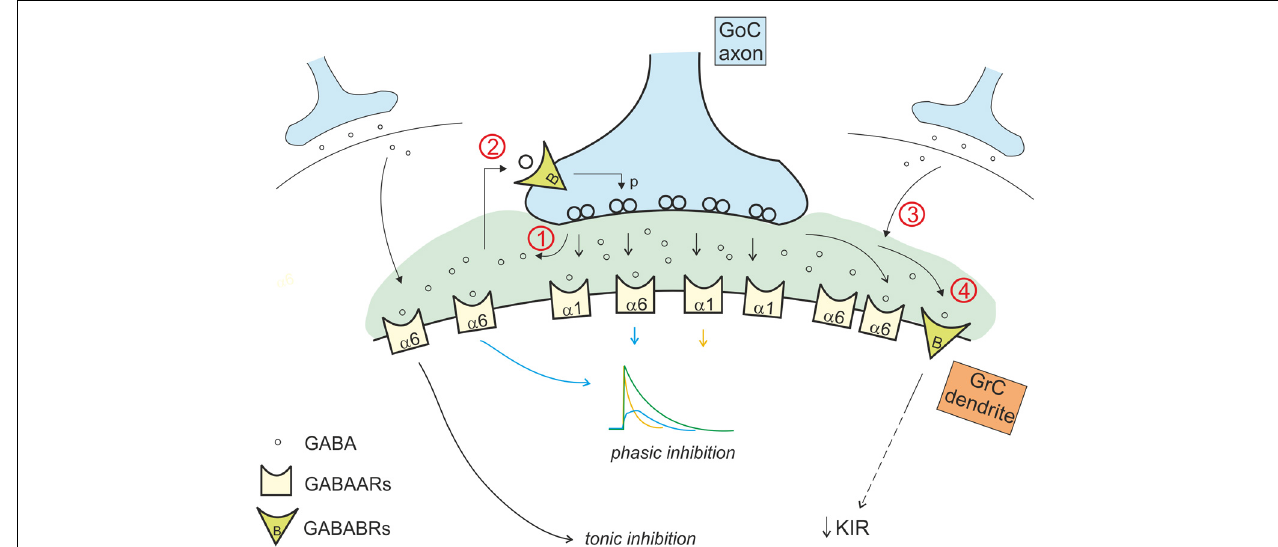
FIGURE 4 | Interaction of the phasic and tonic inhibitory mechanisms in the glomerulus. Phasic and tonic inhibition are not independent but share a number of mechanisms and influence one each other in several ways. (1) GABA released by Golgi cell terminals during phasic inhibition contributes in increasing the level of ambient GABA, that activates extrasynaptic α 6 containing GABA-A receptors, contributing to the tonic conductance (Diaz et al., 2013). (2) The tonic GABA level in the glomerulus is sufficient to